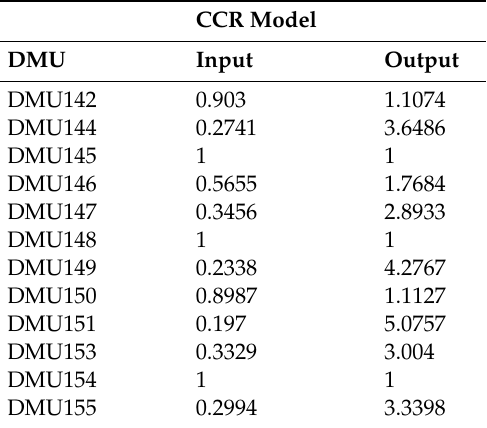
Table 9. CCR method for assessing the e ff ectiveness of machine and equipment manufacturers.